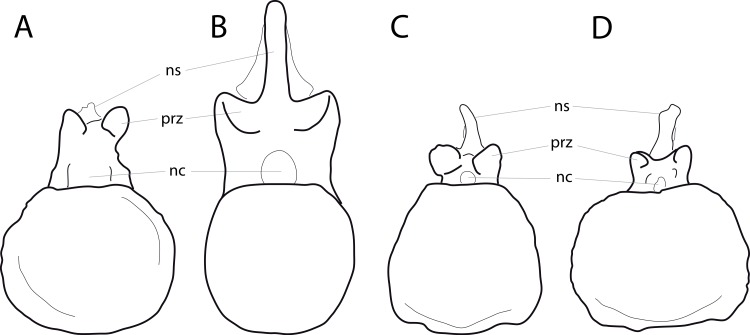
Eusauropod mid-caudal vertebrae.Mid-caudal vertebrae of Losillasaurus giganteus MCNV Lo-32 (A), Isisaurus colberti ISIR335/42 (B; traced from Jain & Bandyopadhyay, 1997), Diplodocus sp. AMNH 655 (C), and Barosaurus lentus AMNH 6341 (D) in anterior view, illustrating the four states of character 334 (A, circular; B, quadrangular; C, trapezoidal; D, flat ventral margin with rounded lateral edges). Abb.: nc, neural canal; ns, neural spine; prz, prezygapophysis. Scaled to same anterior surface height.